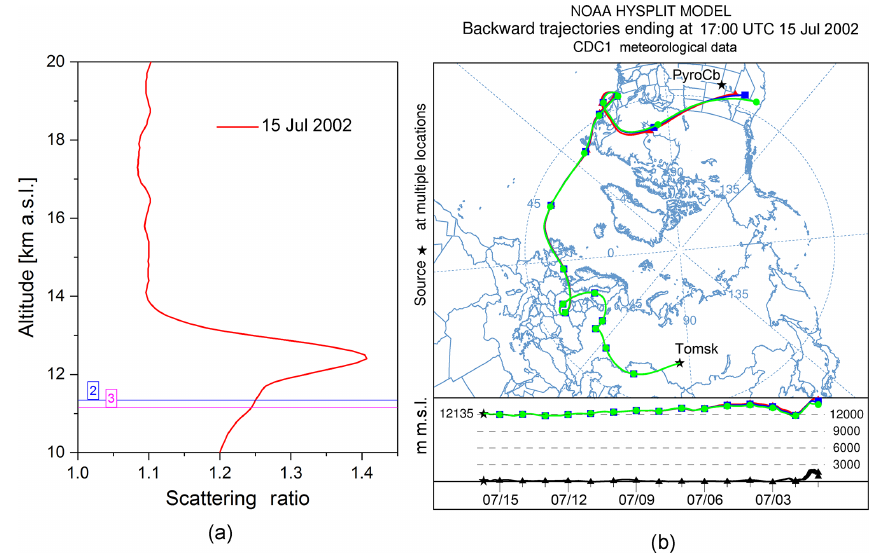
Figure 3. (a) Detection of the Mustang Fire pyroCb plume in the LS over Tomsk. The numbers 2 and 3 indicate the tropopause altitudes estimated in Emeljanovo and Novosibirsk, respectively, at 17:00UTC on 15 July 2002. (b) Air mass backward ensemble trajectories started from altitudes of ∼ 12 . 1km over Tomsk at the same time.